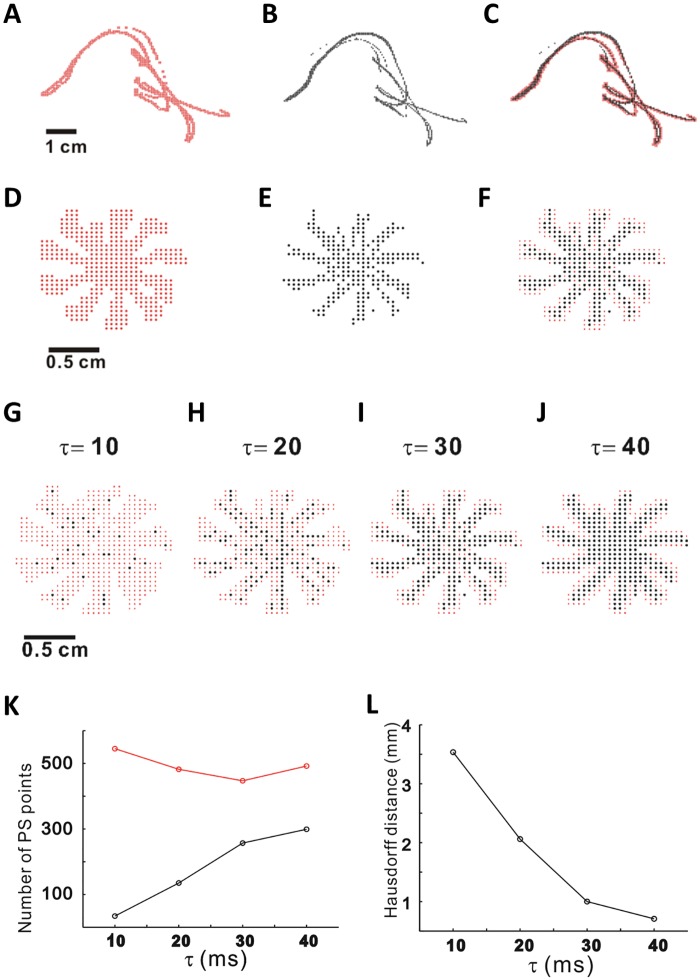
Spatial distributions of PS trajectories and effects of time delay on PS calculation.PS trajectories for the control scenario: (A) using Iyer-Gray method, (B) using location-centric method, (C) combined image. PS trajectories for the 0.3×ICaL scenario: (D) using Iyer-Gray method, (E) using location-centric method, (F) combined image. (G-J) PS points were overlapped for different τ (time delay values) = 10 ms (G), 20 ms (H), 30 ms (I), and 40 ms (J). The number of PS points (K), and Hausdorff distance (L) of Iyer-Gray method (red dots) and location-centric method (black dots).